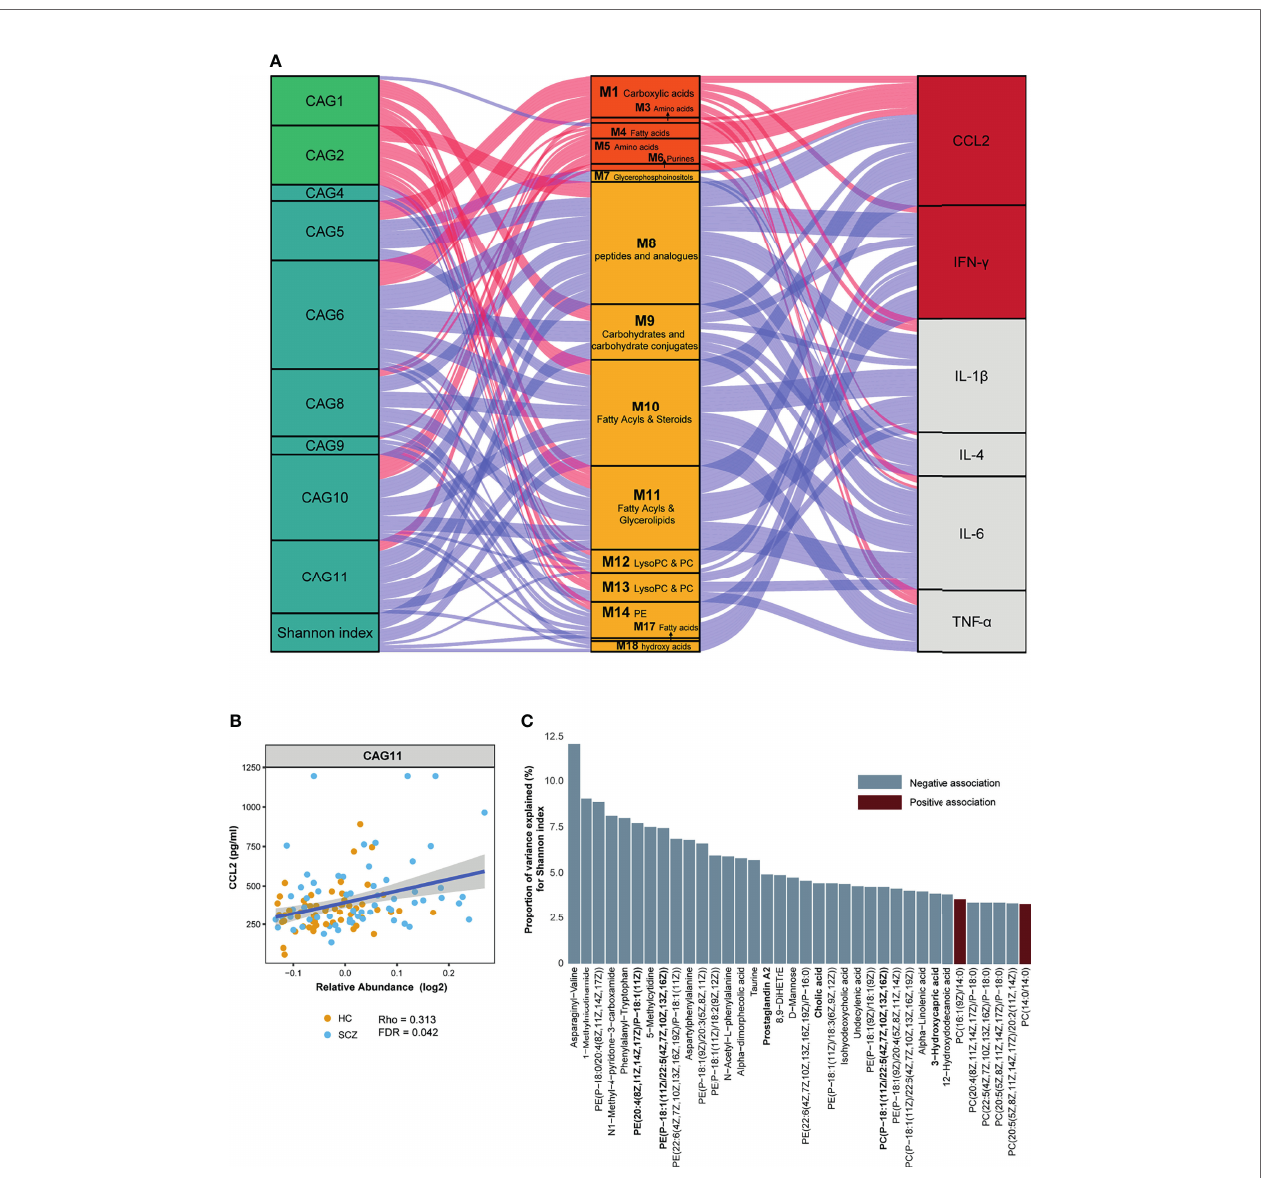
FIGURE 3 | Interrelationship between gut microbiota composition, host metabolic pro fi le, and in fl ammatory cytokines. (A) Visualization of the correlation network according to Spearman correlation analysis between the gut microbiota of signi fi cant co-abundance groups (CAGs) and the in fl ammatory cytokines was mediated by serum metabolites. Red connections indicated positive correlations (Spearman correlation test, FDR < 0.05), whereas blue connections showed correlations that were negative (Spearman correlation test, FDR < 0.05). All correlations were adjusted for age, sex, body mass index, and diet. In the gut microbiota column, the green stratum represented CAGs that were highly enriched in the healthy control (HC) group, and the stratum colored in blue was increased in the schizophrenia (SCZ) group. In the metabolomics column, the orange stratum represented HC-enriched metabotypes, and the claybank stratum represented SCZ-enriched metabotypes. In the cytokines column, the red stratum represented elevated in fl ammatory cytokines in the SCZ group, and the gray represented no difference between the two groups. (B) Scatter plot representing the association between C – C motif chemokine ligand 2 and CAG11 in all subjects. (C) The percentage of variance in Shannon index that was explained by each serum metabolite that was signi fi cantly associated with Shannon index ( P -value < 0.05). For each metabolite, red bars correspond to a positive b -coef fi cient, whereas blue bars correspond to a negative b -coef fi cient. Signi fi cance was assessed using ordinary least squares